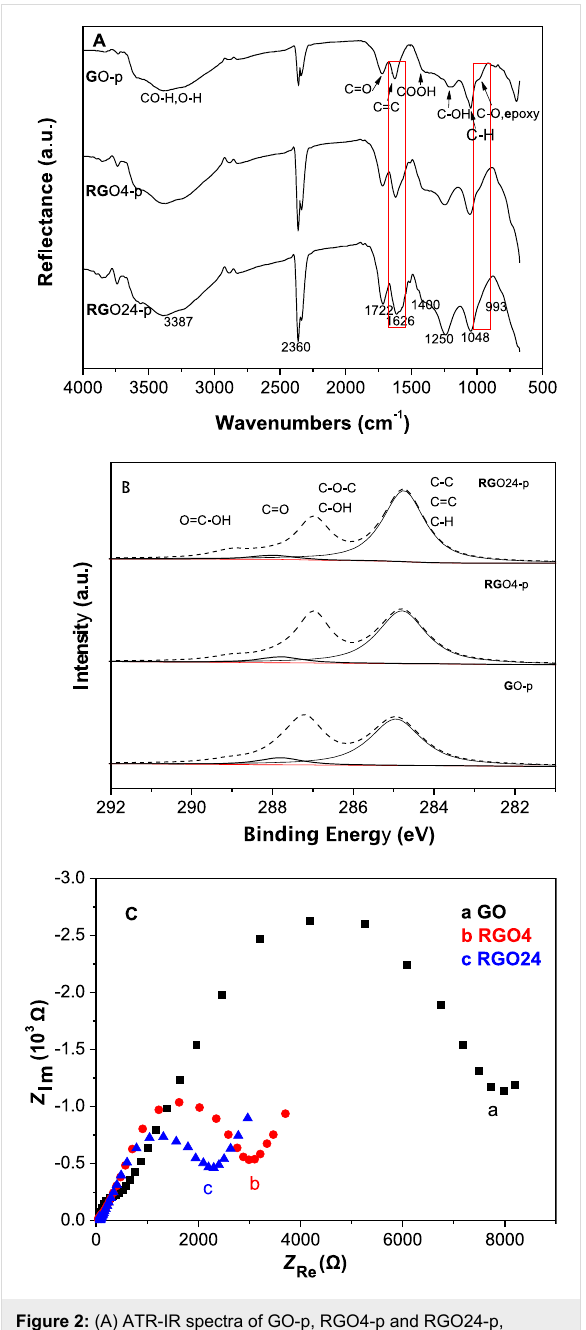
Figure 2: (A) ATR-IR spectra of GO-p, RGO4-p and RGO24-p, (B) XPS spectra of C1s for GO-p, RGO4-p and RGO24-p, and (C) Nyquist diagrams of GO, RGO4 and